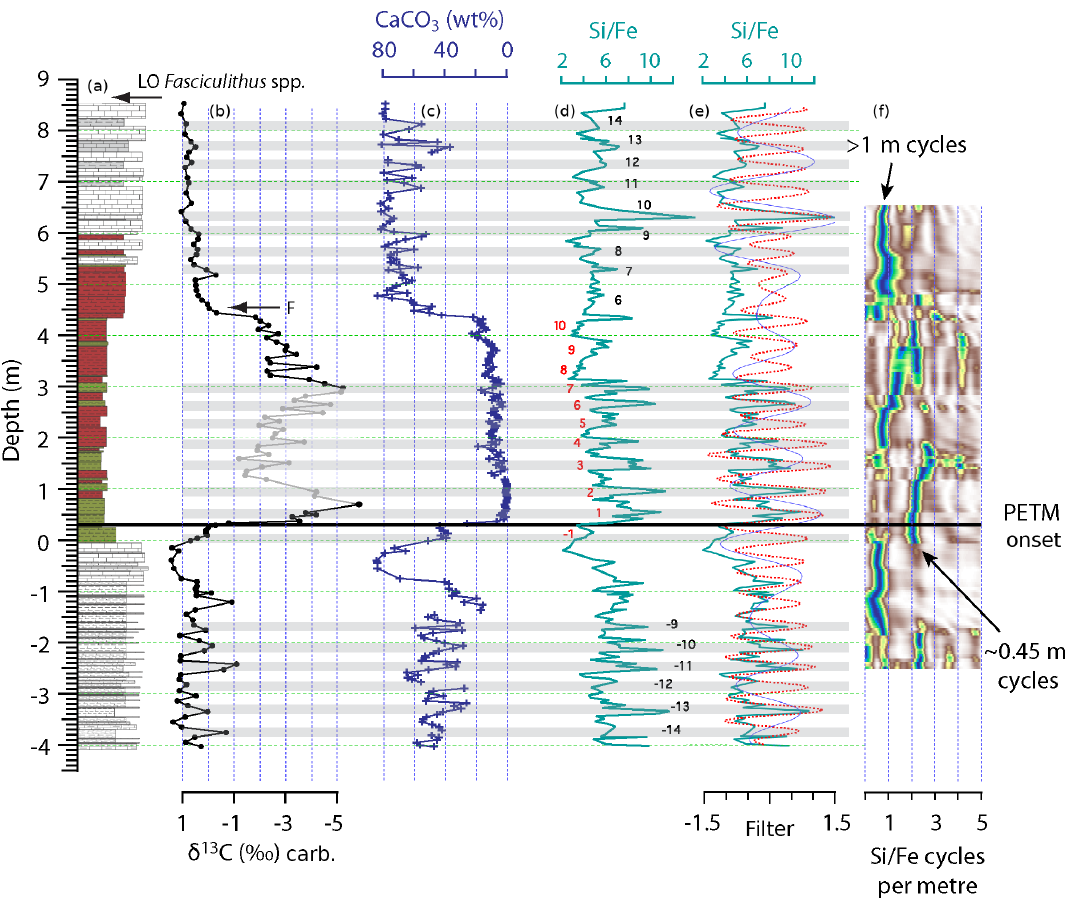
Figure 3. New sediment geochemistry data for the Zumaia section: (a) lithological log produced during sample collection for this study (2011); (b) bulk carbonate δ 13 C; (c) weight percentages of CaO and CaCO 3 from bulk sediment XRF analyses; (d) Si / Fe ratio based on weight percentages of oxides (SiO 2 / Fe 2 O 3 ) from XRF analyses with pre-PETM and post-PETM precession cycles numbered in black, intra-PETM cycles numbered in red; (e) Si / Fe ratios as in (d) with Gaussian filters of the dominant cycles 0.45m (red) and 1m (thin blue line); (f) evolutive spectral analysis for Si /